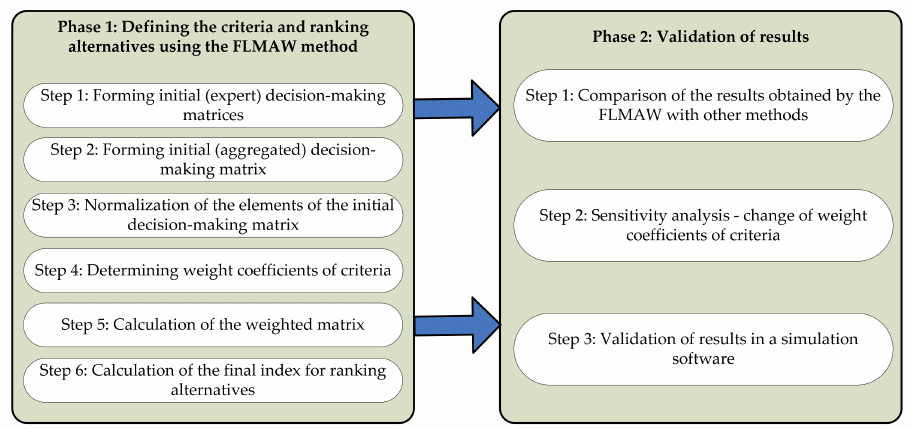
Figure 1. General overview of the model for the LOP